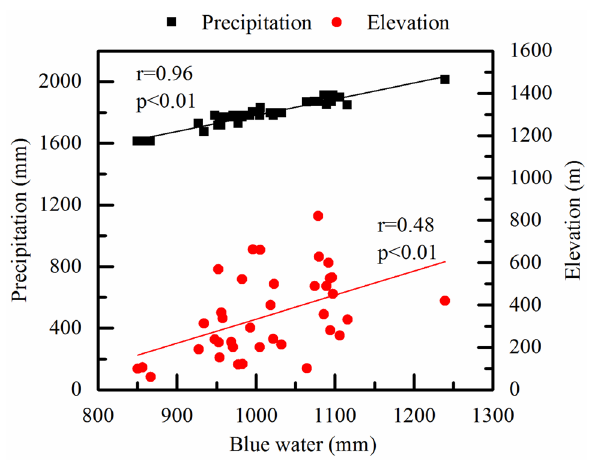
Figure 7. Correlations between BW and precipitation, elevation in the